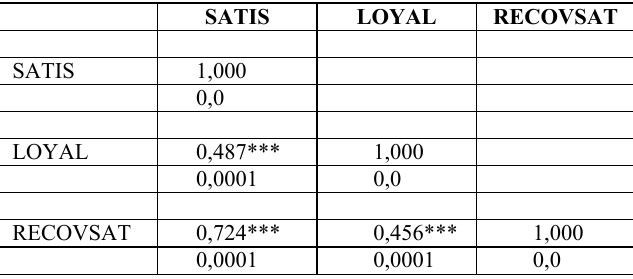
Table 4: Correlation analysis results